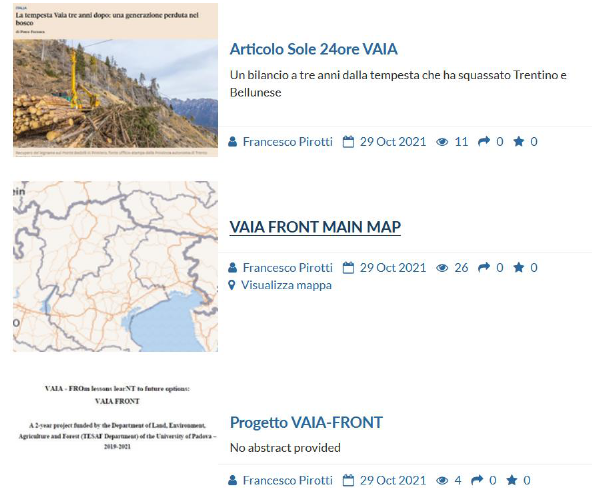
Figure 4. Three items from the VAIA project loaded in ISPRS-SHY – from top to bottom; top is a newspaper article, middle is the map, and bottom is the overall project proposal, which is available as linked